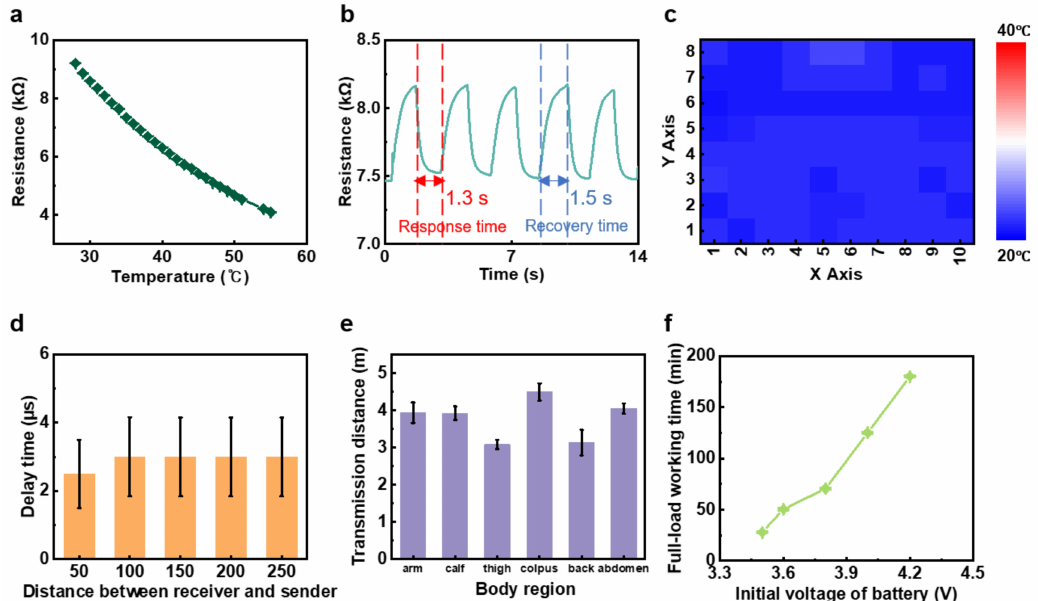
Figure 2. Electrical and operational performance of the WH-sensor. ( a ) Electrical signal of the thermistor versus temperature. ( b ) Electrical response of the NTC thermal sensor under controlled temperature (from 32 to 34 ◦ C) ( c ) Temperature map of the WH-sensor at room temperature (21.5 ◦ C) ( d ) Delay time of the device under distance variances. ( e ) Longest transmission distance at different body parts. ( f ) Full-load working duration of the device depending on the different initial voltages of the